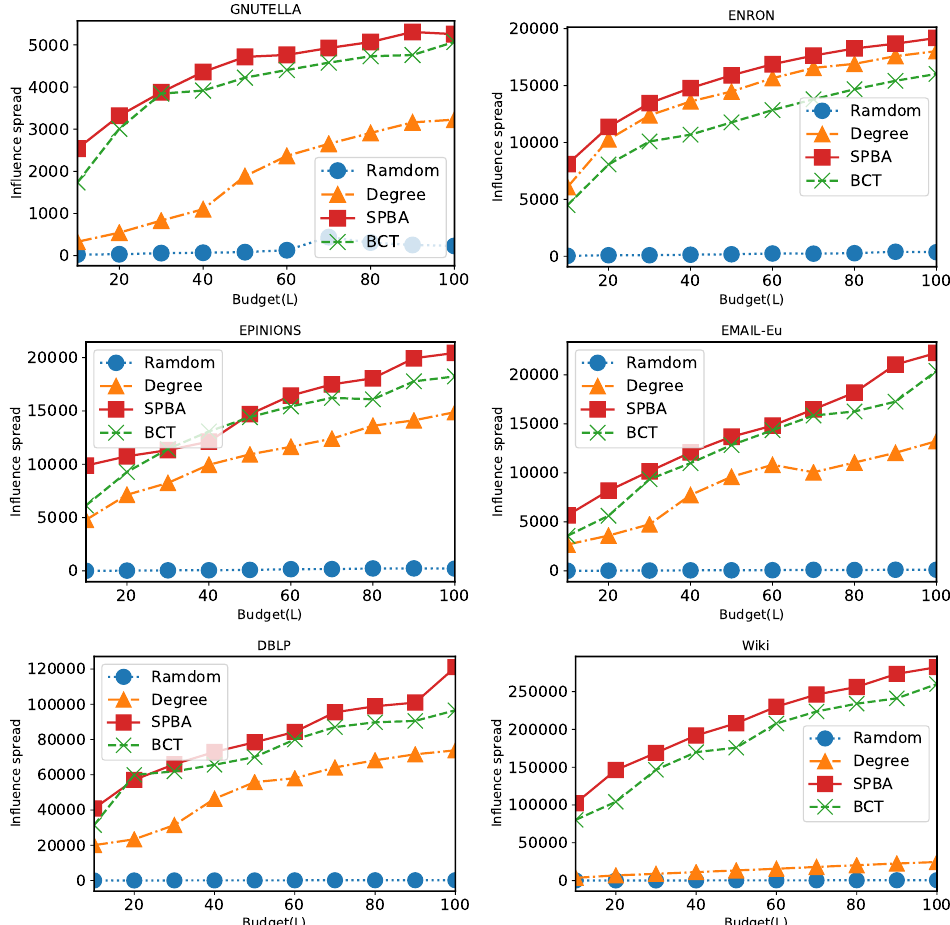
Figure 6. Comparison between different algorithms under general cost setting.